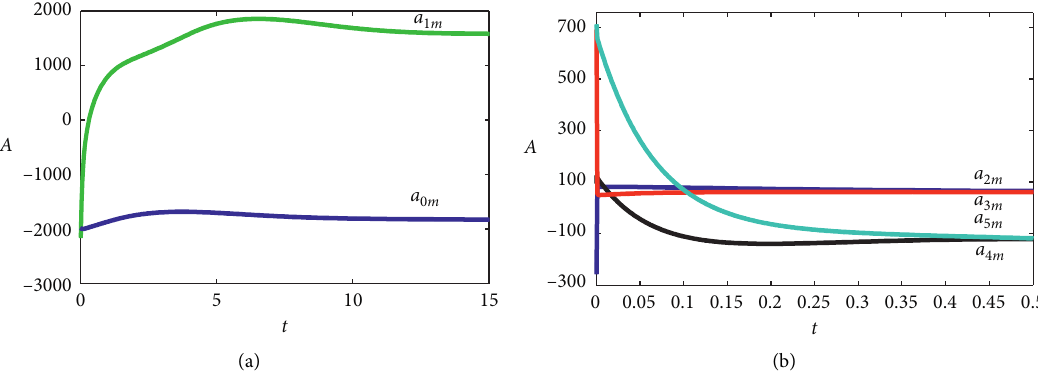
Figure 11: Transient behaviors of a